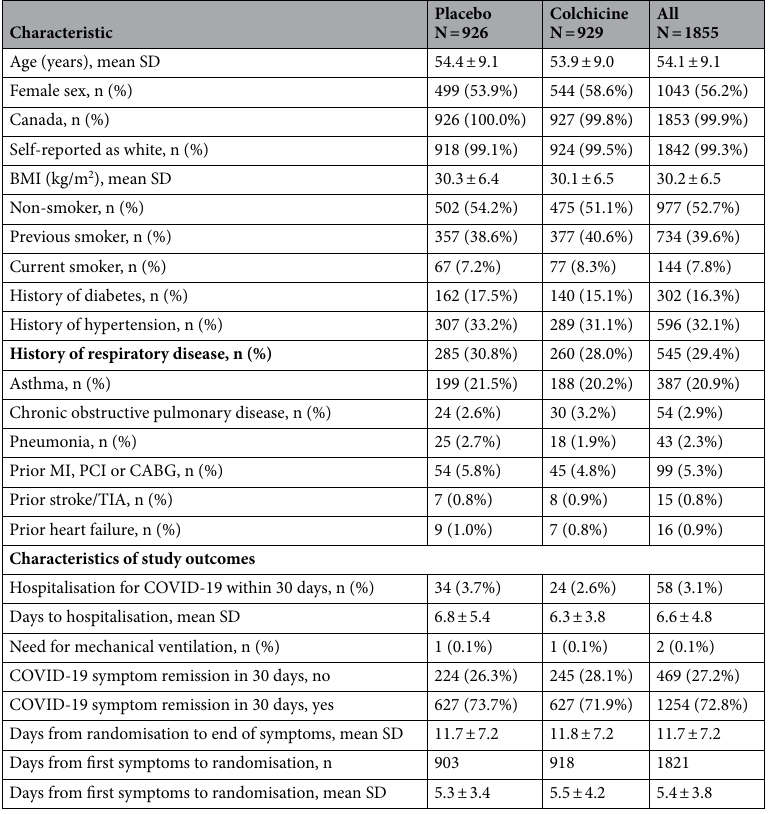
Table 1. Characteristics of the study population. BMI: body mass index; CABG: coronary artery bypass graft; MI: myocardial infarction; N: number of patients; PCI: percutaneous coronary intervention; SD: standard